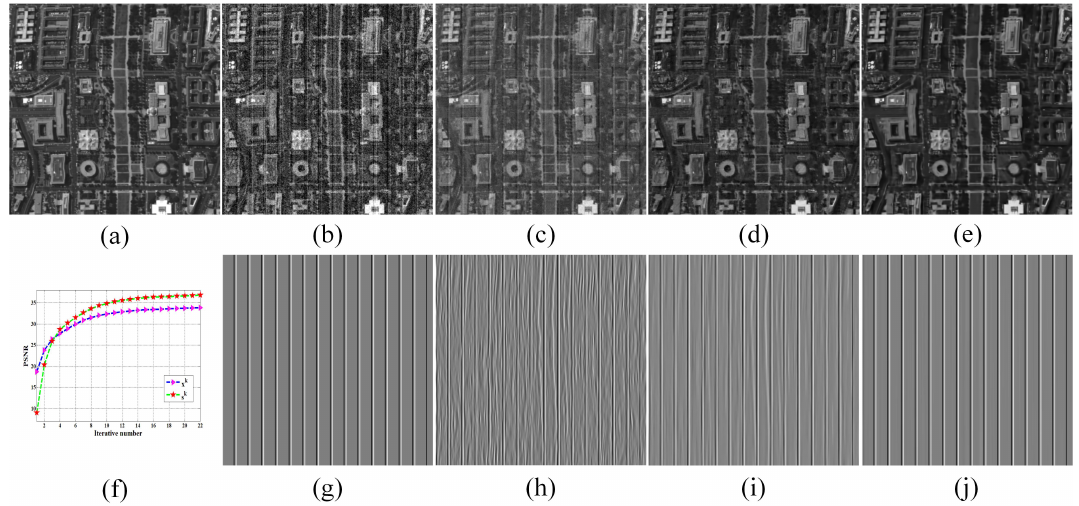
Figure 7. The intermediate results of x k and s k on the SWDCM image in Figure 5g at different iterations. Where noise level σ = 25, the proportion P and the intensity I of the periodical stripe are respectively 0.1 and 50, and the width of each stripe is 20 pixels. ( a ) Ground-truth. ( b ) Degraded SWDCM image. ( c – e ) Visual images respectively at the 5rd, 13th, and 19th. ( f ) Convergence curves of x and s . ( g ) Ground-truth stripe. ( h – j ) Visual stripes respectively at the 5th, 13th, and 19th iteration.